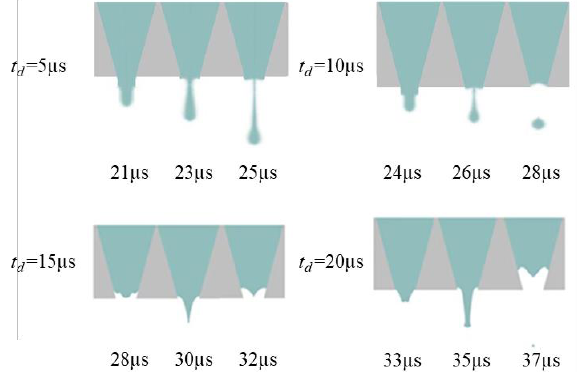
Figure 13. Simulation results of droplet formation at the nozzle at different t d .